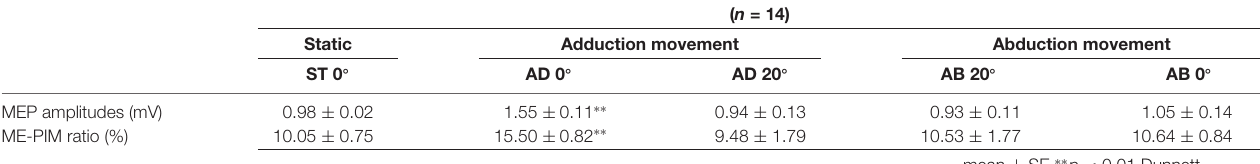
TABLE 1 | Mean motor evoked potential (MEP) amplitude and MEP/M ratio during passive movement in Experiment 1.